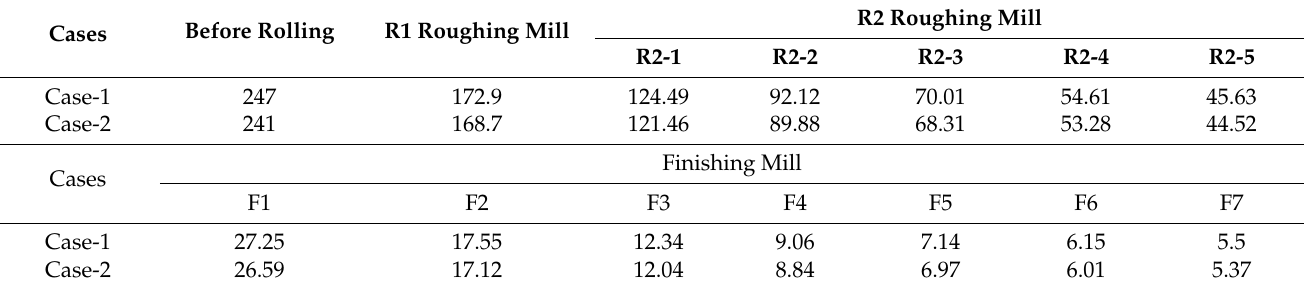
Table 2. IF steel hot-rolling schedules with thicknesses of plates for two cases (unit: mm).